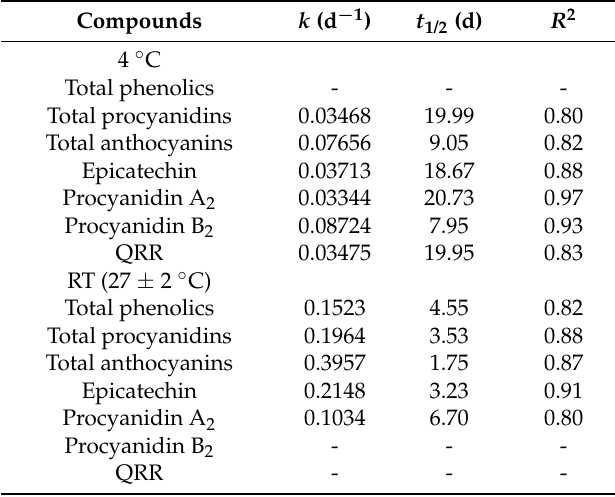
Table 2. Degradation kinetic parameters of phenolics in litchi pericarp stored at 4 ◦ C and RT (27 ± 2 ◦ C) as a function of storage time. k is the kinetic rate constant (d − 1 ); t 1/2 represents the half-life (d); and R 2 is the coefficient of determination. Compounds k (d − 1 ) t 1/2 (d) R 2 4 ◦ C Total phenolics - - - Total procyanidins 0.03468 Total anthocyanins